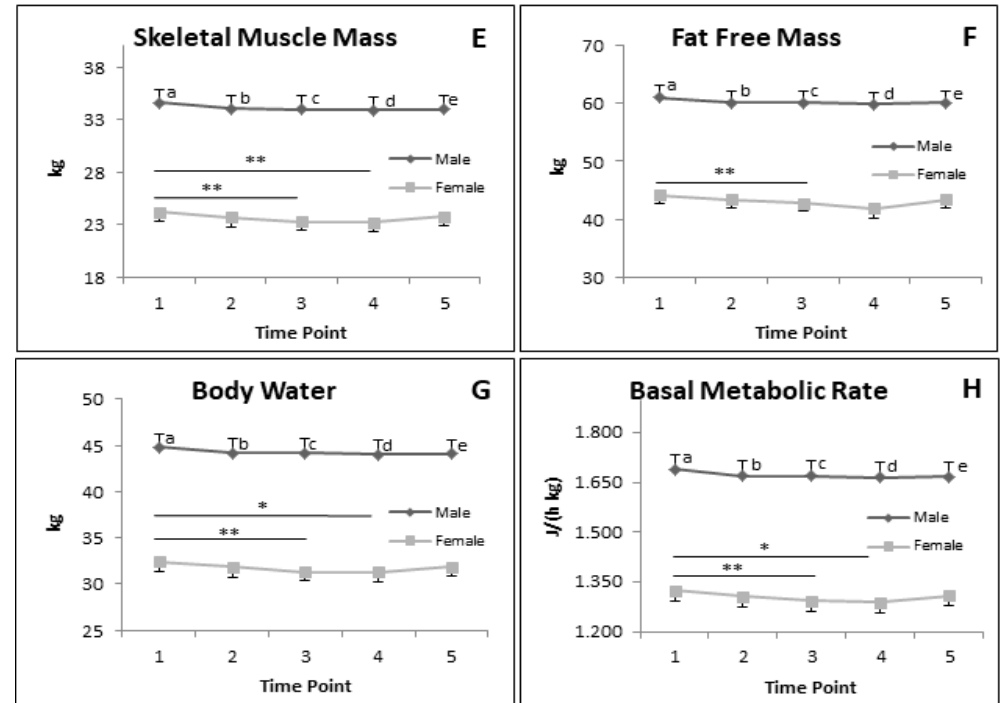
Figure 6. Alteration of BC during RF in subgroup male ( n = 19) of and female ( n = 15). (a–e) significant difference between male and female at T1, T2, T3, T4 and T5, respectively. ( A : Body weight; B : Body mass index; C : Body fat mass; D : Body fat percentage; E : Skeletal muscle mass; F : Fat free mass; G : Body water mass; H : Basal metabolic rate). Data presented in mean and SEM. * p < 0.05; ** p < 0.01.